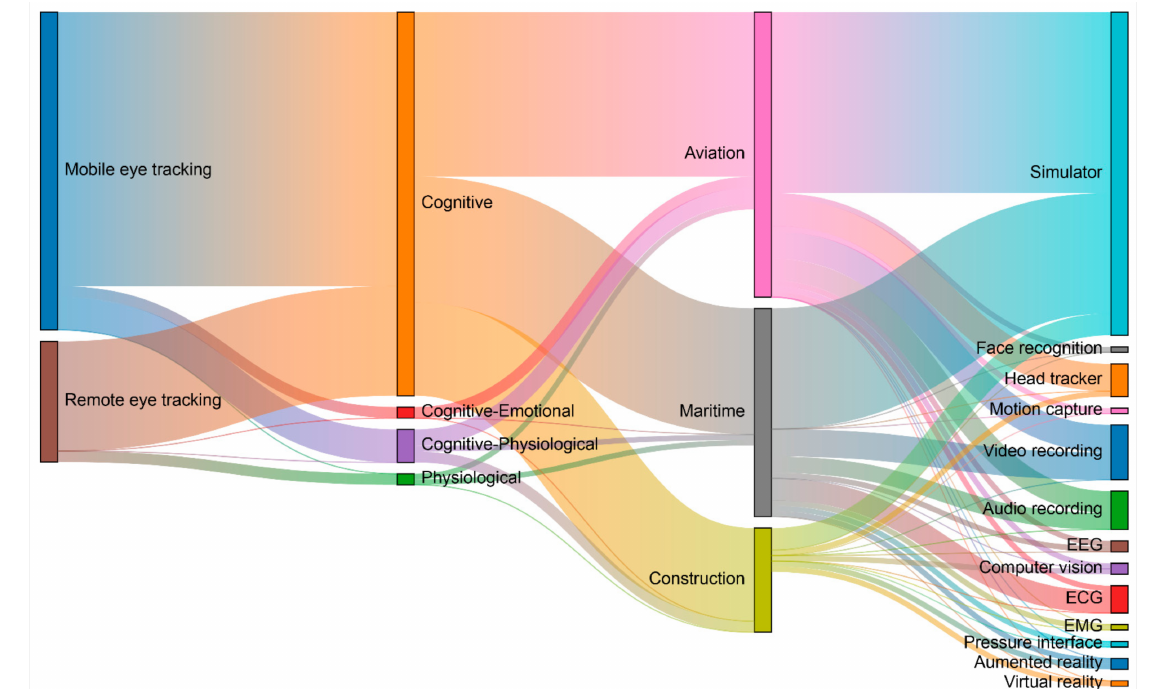
Figure 11. Different applications of mobile and remote eye tracking devices in relation to the study of human aspects, industry, and integration with various